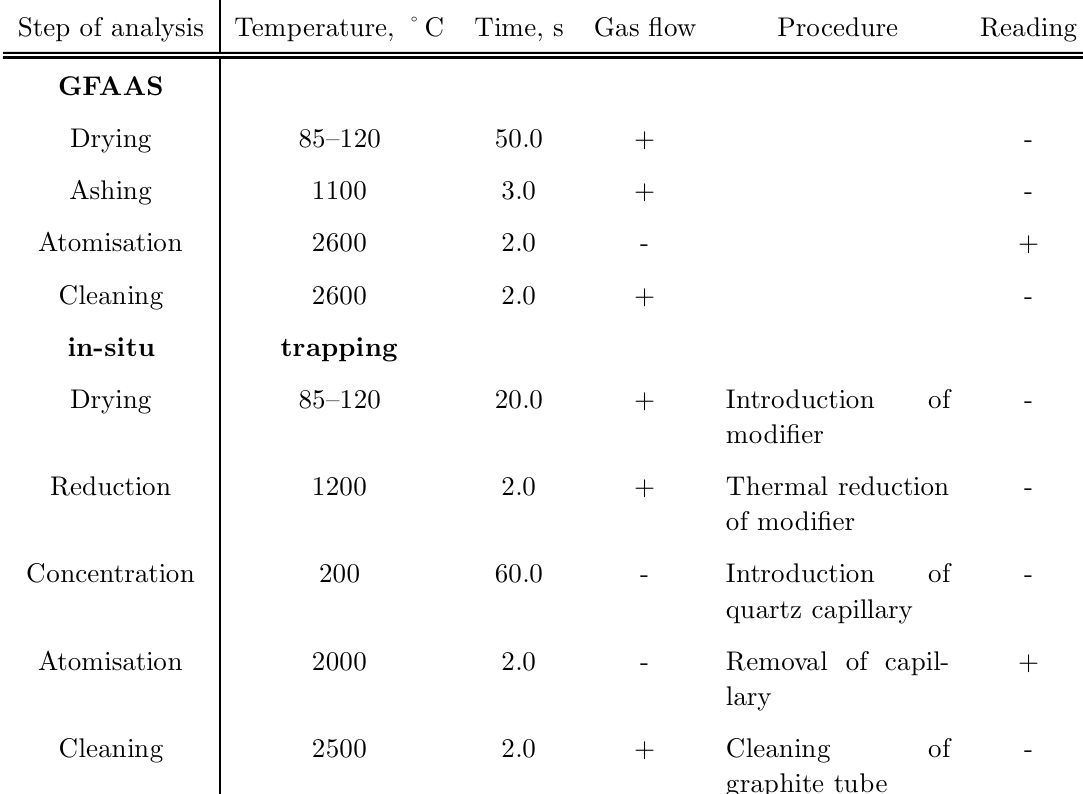
Table 2 The temperature programme followed for determination of selenium by atomic ab- sorption spectrometry with atomisation in a graphite tube (GFAAS) followed for determination of selenium by the method of atomic absorption spectrometry with generation of hydrides and in-situ preconcentration in a graphite tube (in-situ